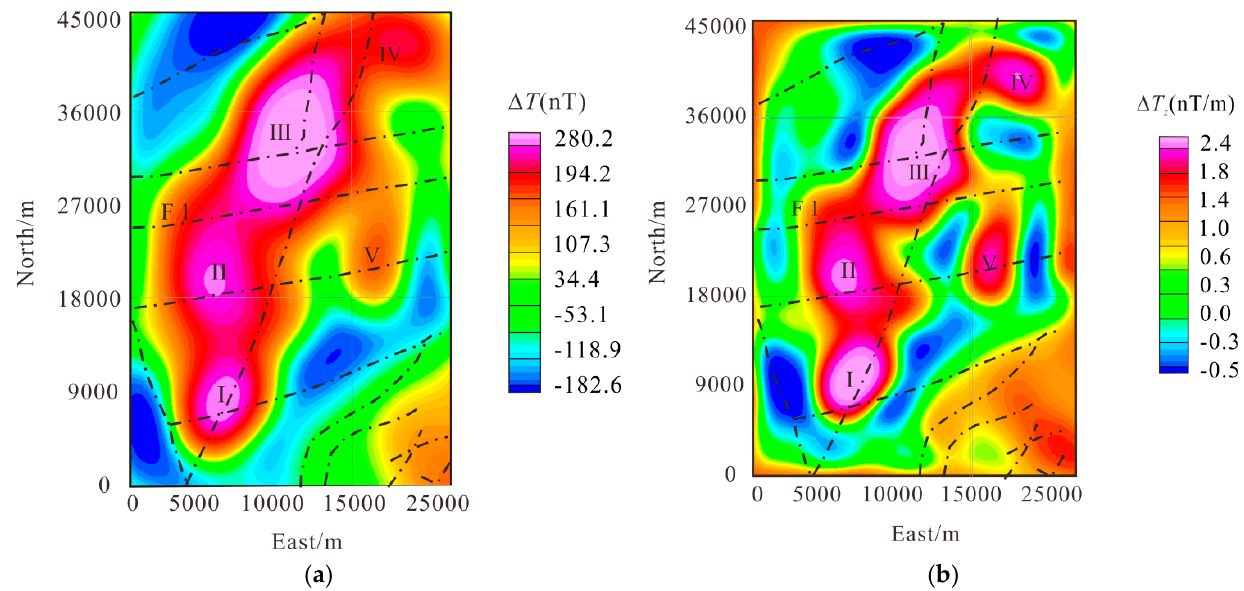
Figure 8. ( a ) Airborne magnetic anomaly by high-pass filtering. ( b ) Airborne magnetic gradient anomaly.